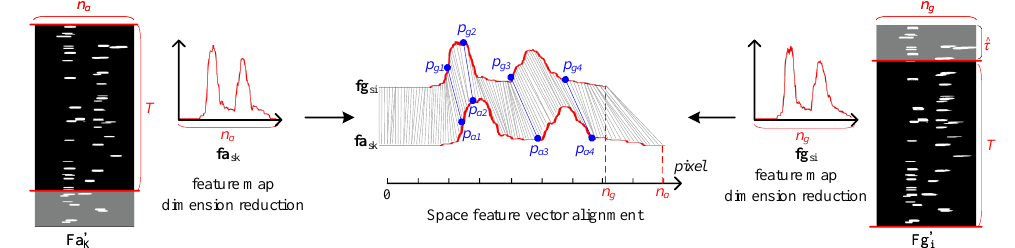
Figure 6. Cross-view spatial alignment. The matched feature map Fa (cid:48) reduced from 2D map to 1D spatial feature vector, as denoted by fa sk and fg si . We then match the two spatial sequences by DTW ( middle ). Several corresponding pixel pairs labeled in blue are returned as